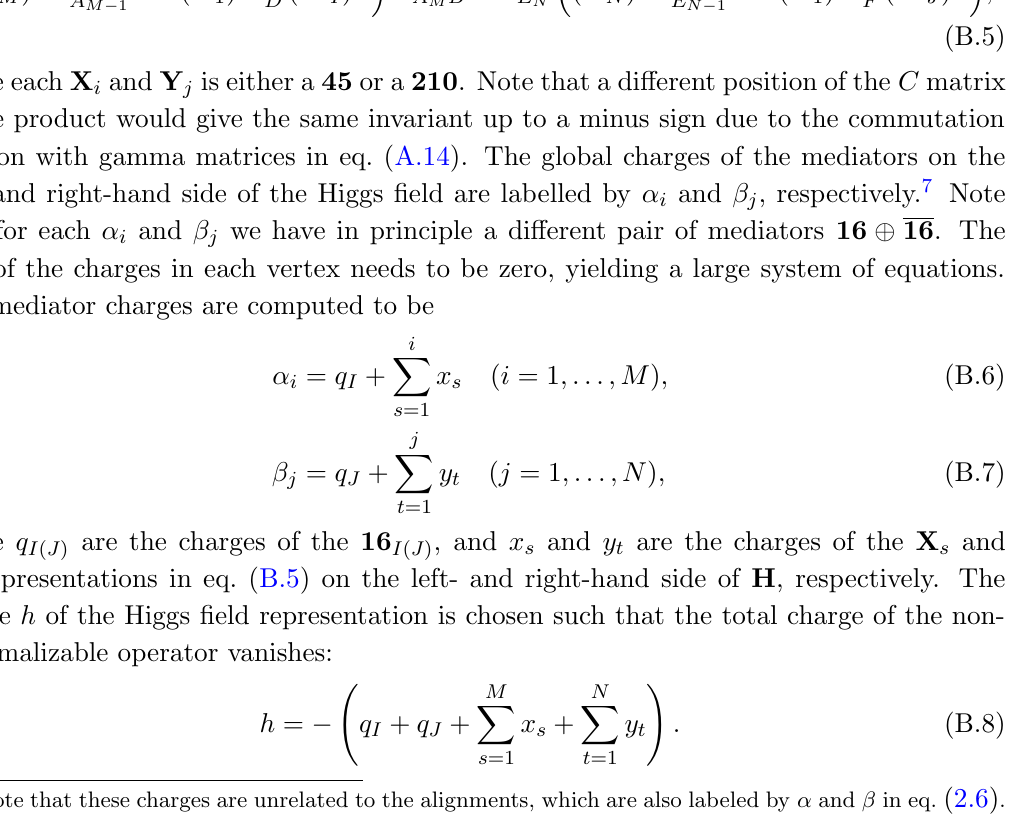
Figure 10 . The global charge assignments to the (cid:12)elds in (cid:12)gure 8: h and q of the H and 16 , respectively. On the left-hand side of the H , the 45 s or 210 s have charges x i I ( J ) and the mediators 16 , 16 carry charges (cid:11) i , (cid:0) (cid:11) i . Analogous labels are used on the right-hand side of H with replacements x i 7! y i and (cid:11) i 7! (cid:12) i